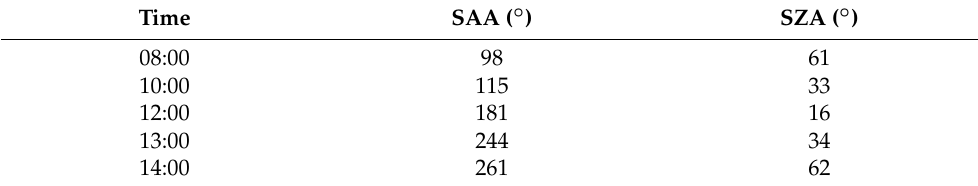
Table 3. Solar geometric conditions for estimating shadow